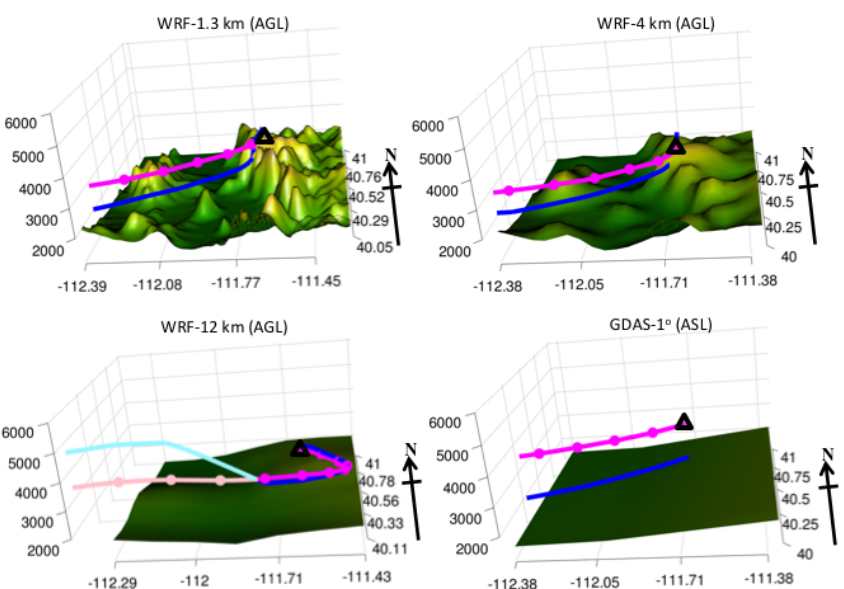
Figure 7. Three dimensional plots of the terrain over a domain of ∼ 1 ◦ × 1 ◦ surrounding HDP, as resolved by the WRF and GDAS models at various grid spacings. The HDP site is denoted as a triangle. Also shown is the average back trajectory, derived by averaging locations of the numerous stochastic trajectories simulated by STILT, driven by the various WRF meteorological fields and the global GDAS field. Back trajectories were started from HDP at 02:00MST (09:00UTC). Points indicate trajectory locations every hour, as the trajectory moves back from the site indicated as points. Magenta portions of the trajectory refer to the nighttime (19:00–07:00MST), while pink portions indicate the daytime (07:00–19:00MST). In addition, the PBL heights averaged along the back trajectory are shown as the blue